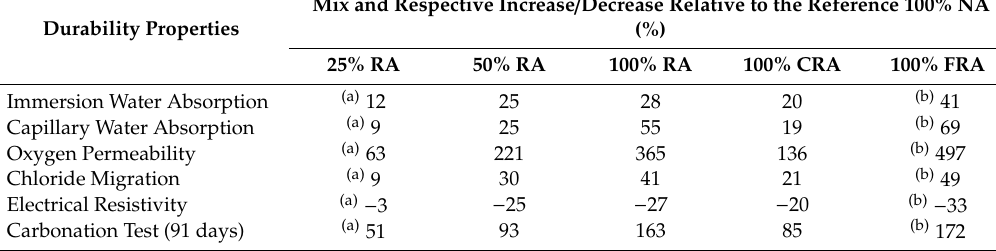
Table 12. Tests results summary at 28 days for all